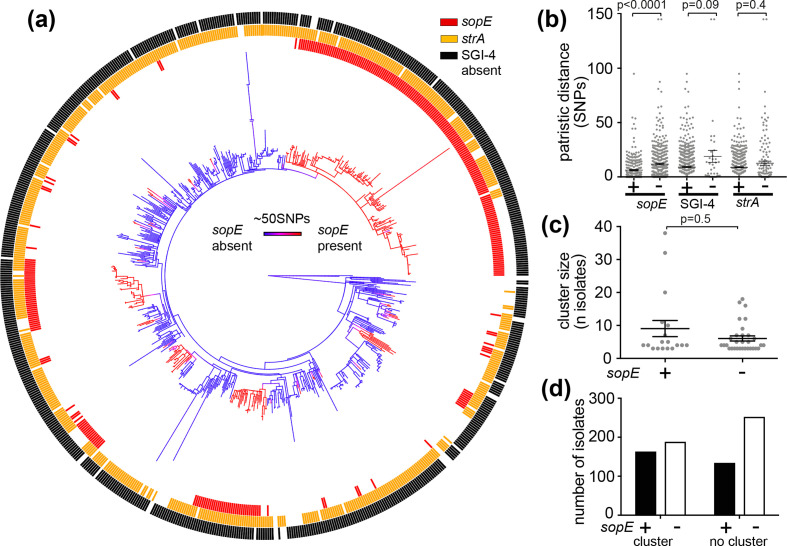
Multiple acquisitions of sopE by monophasic S. Typhimurium from UK human salmonellosis subjects were associated with clonality and transmissibility of the isolates. (a) ML phylogenetic tree of monophasic S. Typhimurium ST34 isolated in the UK from human infections between April 2014 and March 2015 displaying ancestral state reconstruction for sopE and the distribution of sopE and strA genes and of the SGI-4. The posterior probability associated with sopE presence or absence inferred by stochastic character mapping is plotted on the tree as a colour gradient of blue (absent) to red (present). (b) Distribution of pairwise patristic distance, expressed as the number of SNPs, for isolates encoding and lacking sopE, the SGI-4 and strA. Isolates harbouring sopE displayed significantly lower patristic distances than isolates without sopE (Mann–Whitney test, P value 0.0001), while the difference of patristic distance between isolates positive and and negative for the SGI-4 and strA was not statistically significant (Mann–Whitney test, SGI-4 P value=0.09, strA P value=0.4). (c) Size of transmission clusters of sopE-positive and sopE-negative monophasic S. Typhimurium isolates. Clusters were defined as groups of ≥3 isolates sharing the same SNP address at a five single-linkage SNPs level. Isolates with sopE were associated with larger transmission clusters, but the difference was not statistically significant (Mann–Whitney test, P value 0.5). (d) Number of sopE-positive and sopE-negative isolates that were or were not associated with transmission clusters. Isolates with sopE were significantly more associated with transmission clusters (Fisher’s exact test, P value 0.01).